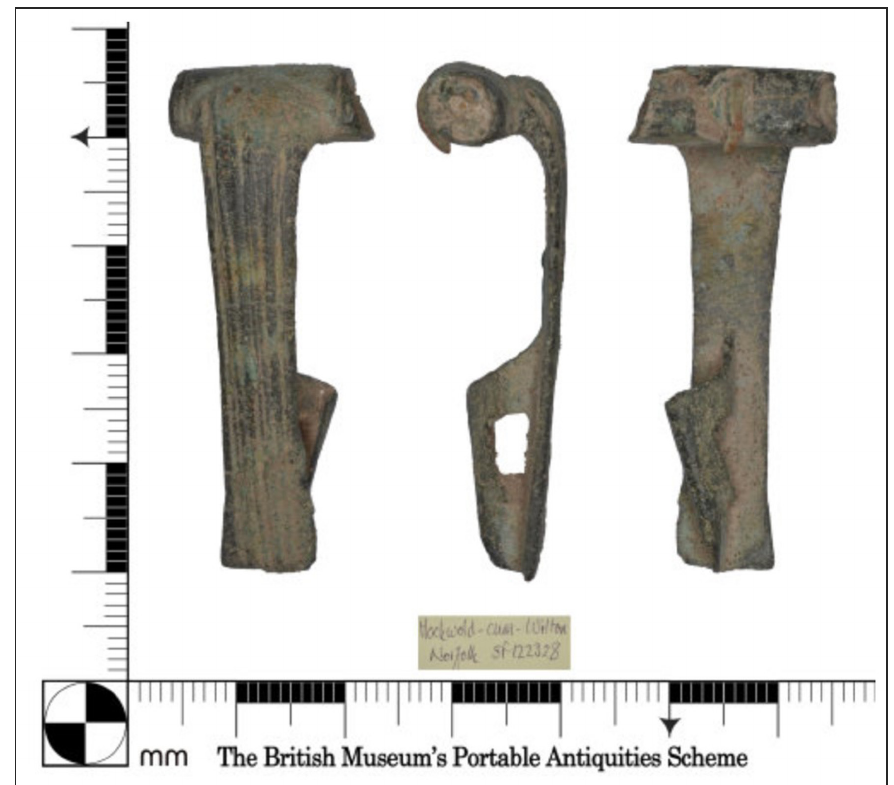
Figure 3: Bow brooch found in Norfolk (Image curtsey of the Portable Antiquities Scheme, Record ID: